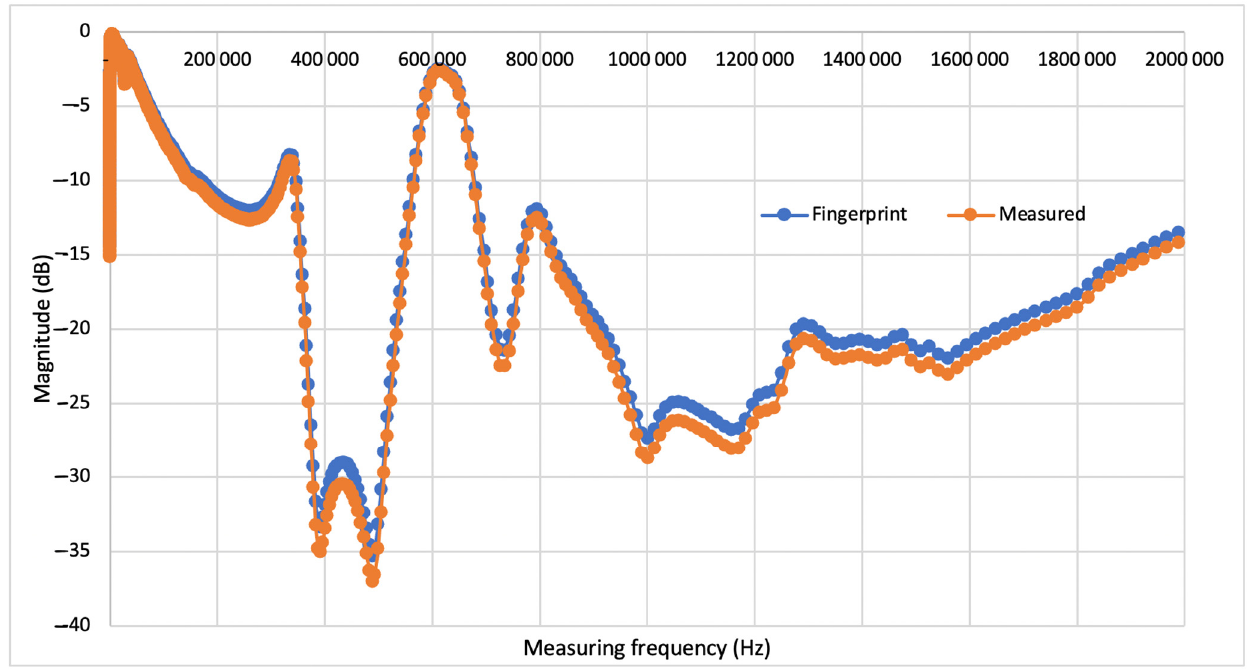
Figure 4. Case study 1: FRA Measurement.